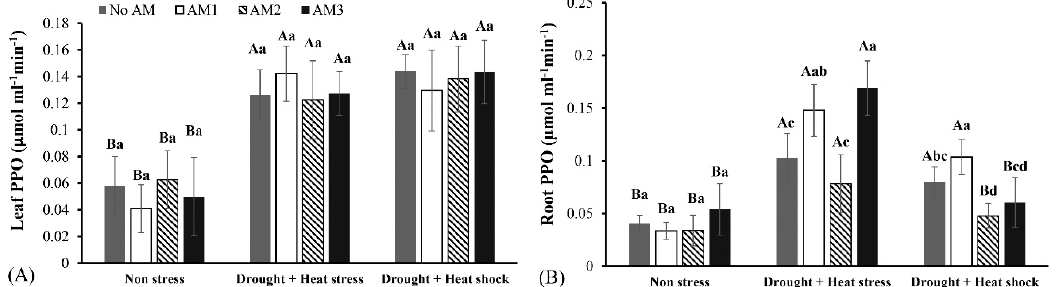
Figure 3. The activity of polyphenol oxidase (PPO) in leaves ( A ) and roots ( B ) of non-inoculated plants (No AM) and plants inoculated by R. irregularis (AM1), F. mosseae (AM2), or F. coronatum (AM3) subjected to non-stress (NoS), drought + heat stress (D + H), and drought + heat shock (D + HS). Each bar represents the mean and standard deviation (n = 4). Different minuscules indicate significant differences among treatments under the same conditions (no stress, drought + heat stress, or drought + heat shock) by Duncan’s post hoc test at p ≤ 0.05. Different capital letters indicate significant differences of the same treatments (No AM, R. irregularis, F. mosseae, or F. coronatum ) under different conditions (no stress, drought + heat stress, and drought + heat shock) by Duncan’s post hoc test at p ≤ 0.05.